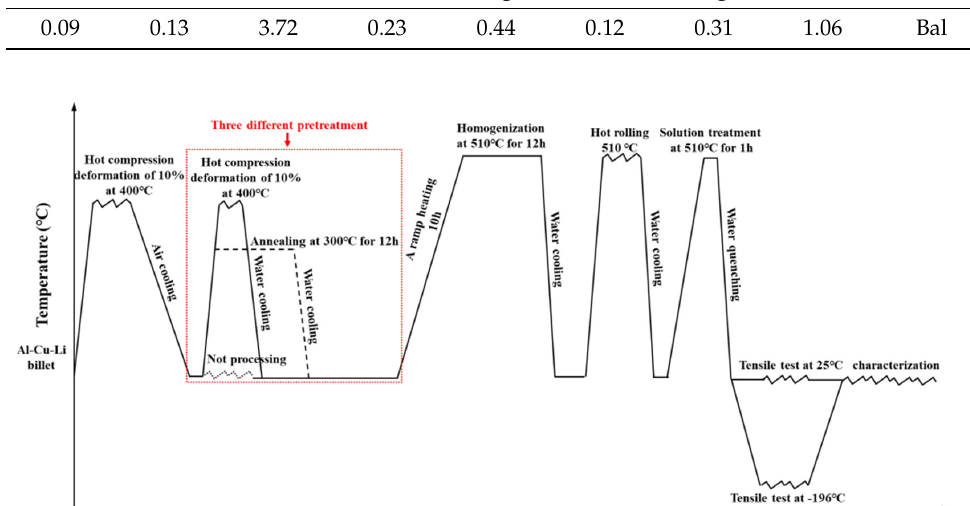
Figure 1. Schematic diagram for the whole heat treatment and test conditions.